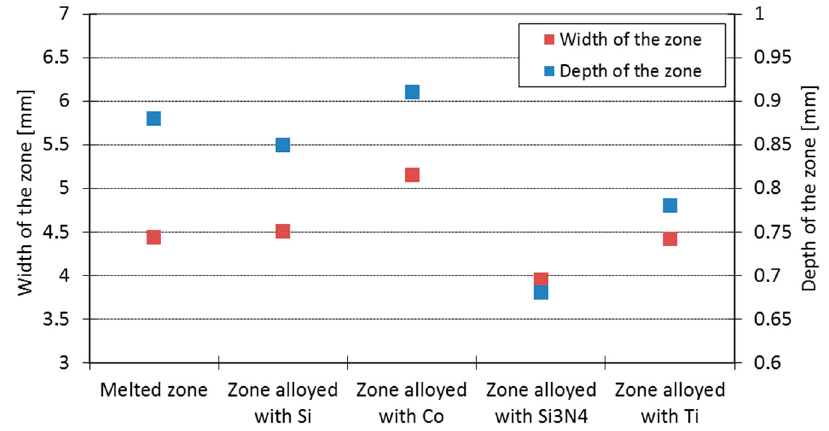
Figure 10. Dimensions of the melted zone and the alloyed zones after laser alloying with silicon, cobalt, silicon nitride, and titanium using the same laser beam parameters.